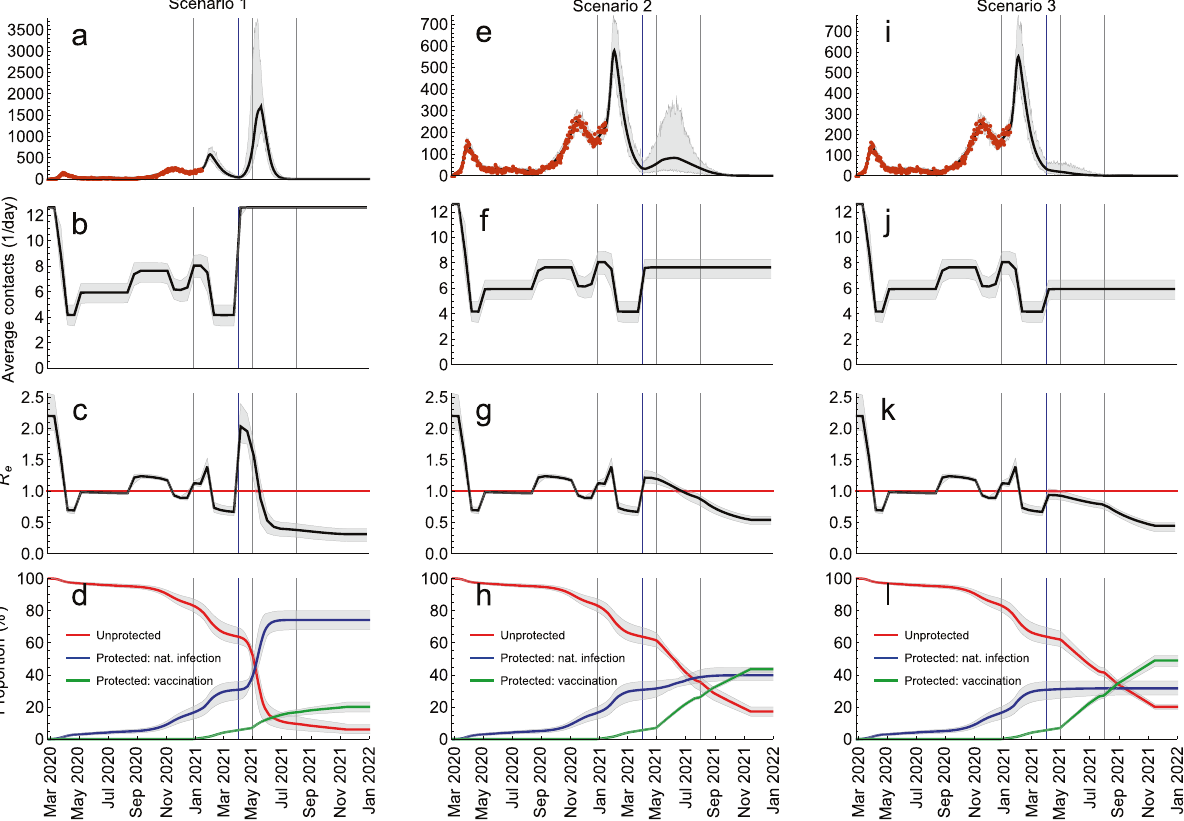
Fig. 6 Scenarios for relaxation of control measures. a – d Lifting all measures so that contact rates in the population return to the pre-pandemic level. e – h Partial lifting of measures so that contact rates increase to the level of September – October 2020. i – l Partial lifting of measures so that contact rates increase to the level of June – August 2020. The blue vertical lines indicate the mid-point of the transition (1 April 2020). The gray vertical lines indicate the starting dates for different vaccination phases (Table 1). The red horizontal line denotes R e = 1. The hospitalization data are shown as red dots. The thick solid lines are the median trajectories estimated from the model. The gray shaded regions correspond to 95% credible